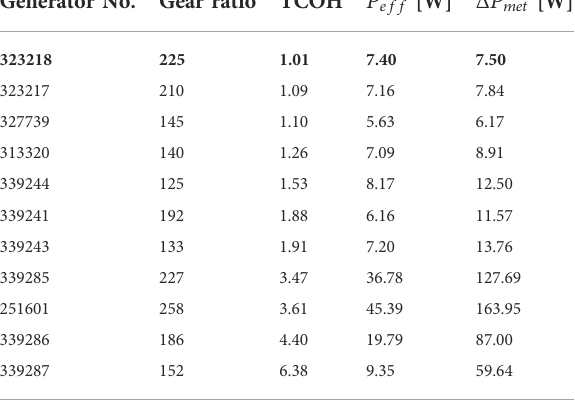
TABLE 2 Optimization results for each of the